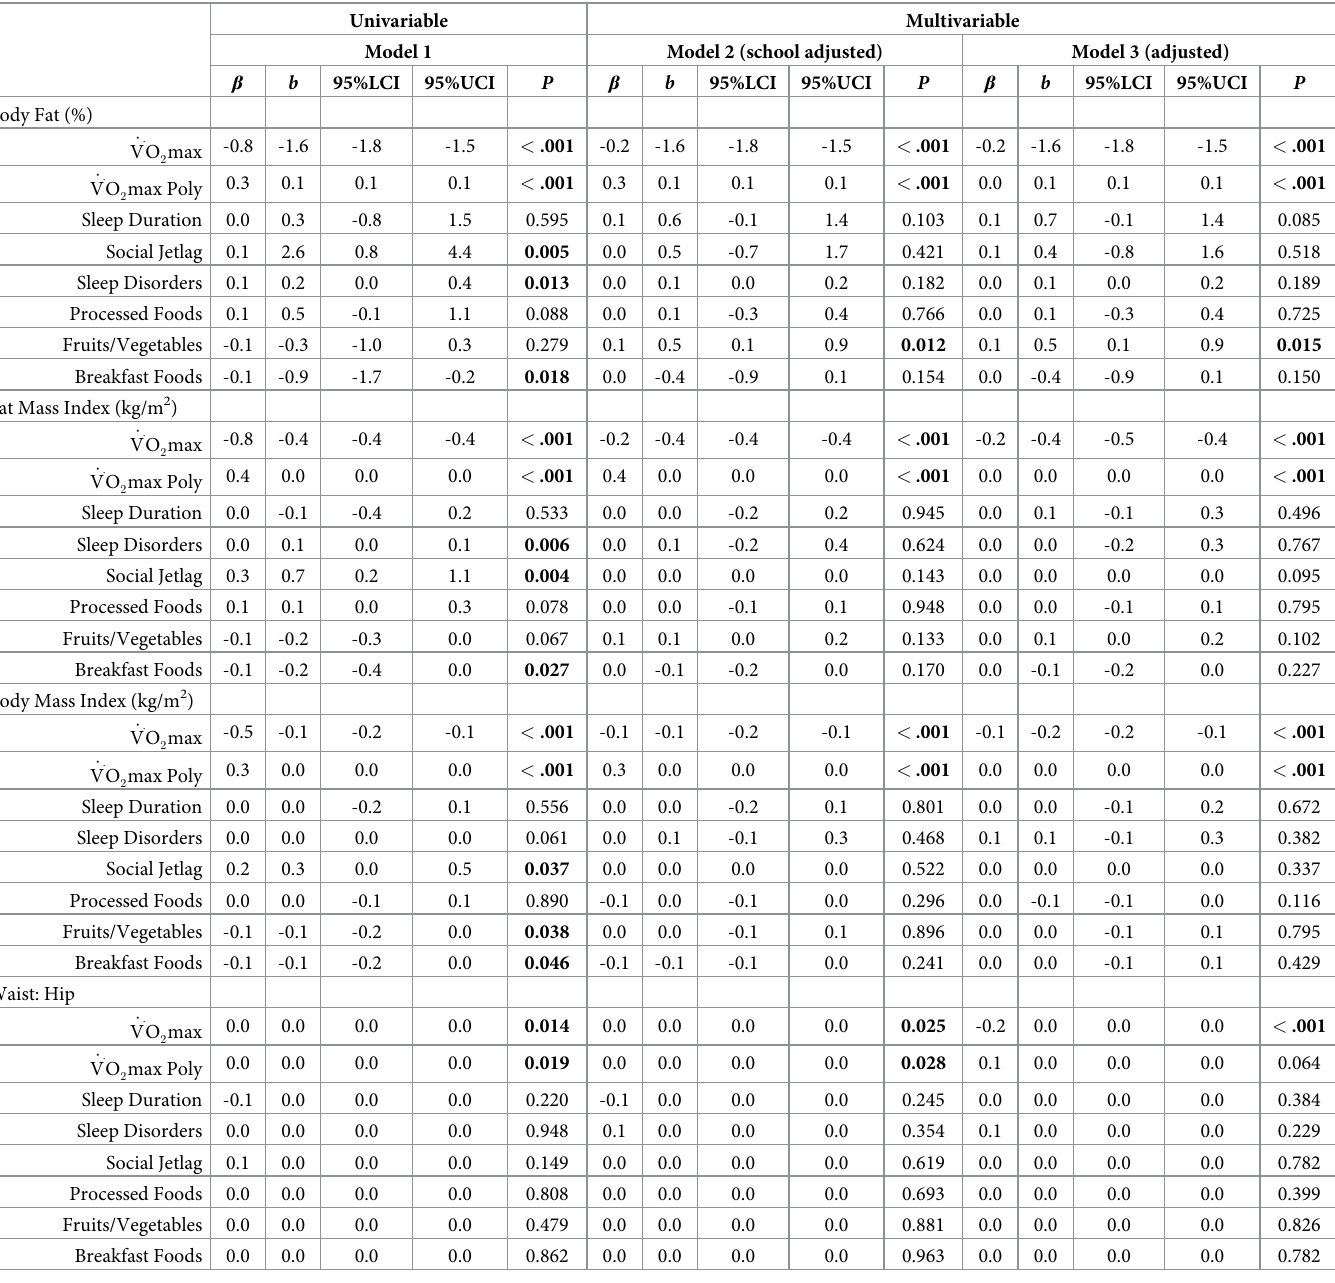
Table 2. Linear association between adiposity and lifestyle